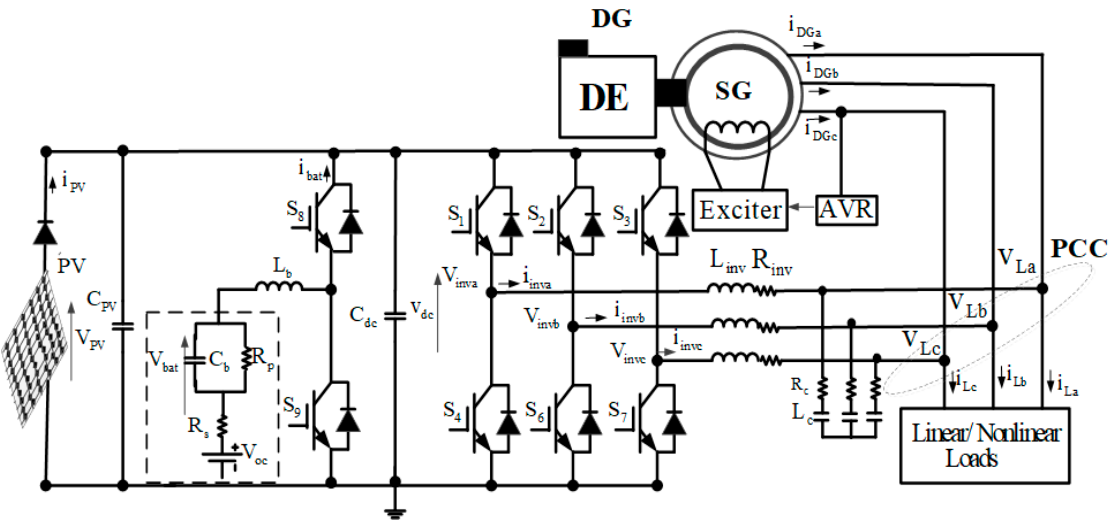
Figure 1. The standalone microgrid configuration under study.